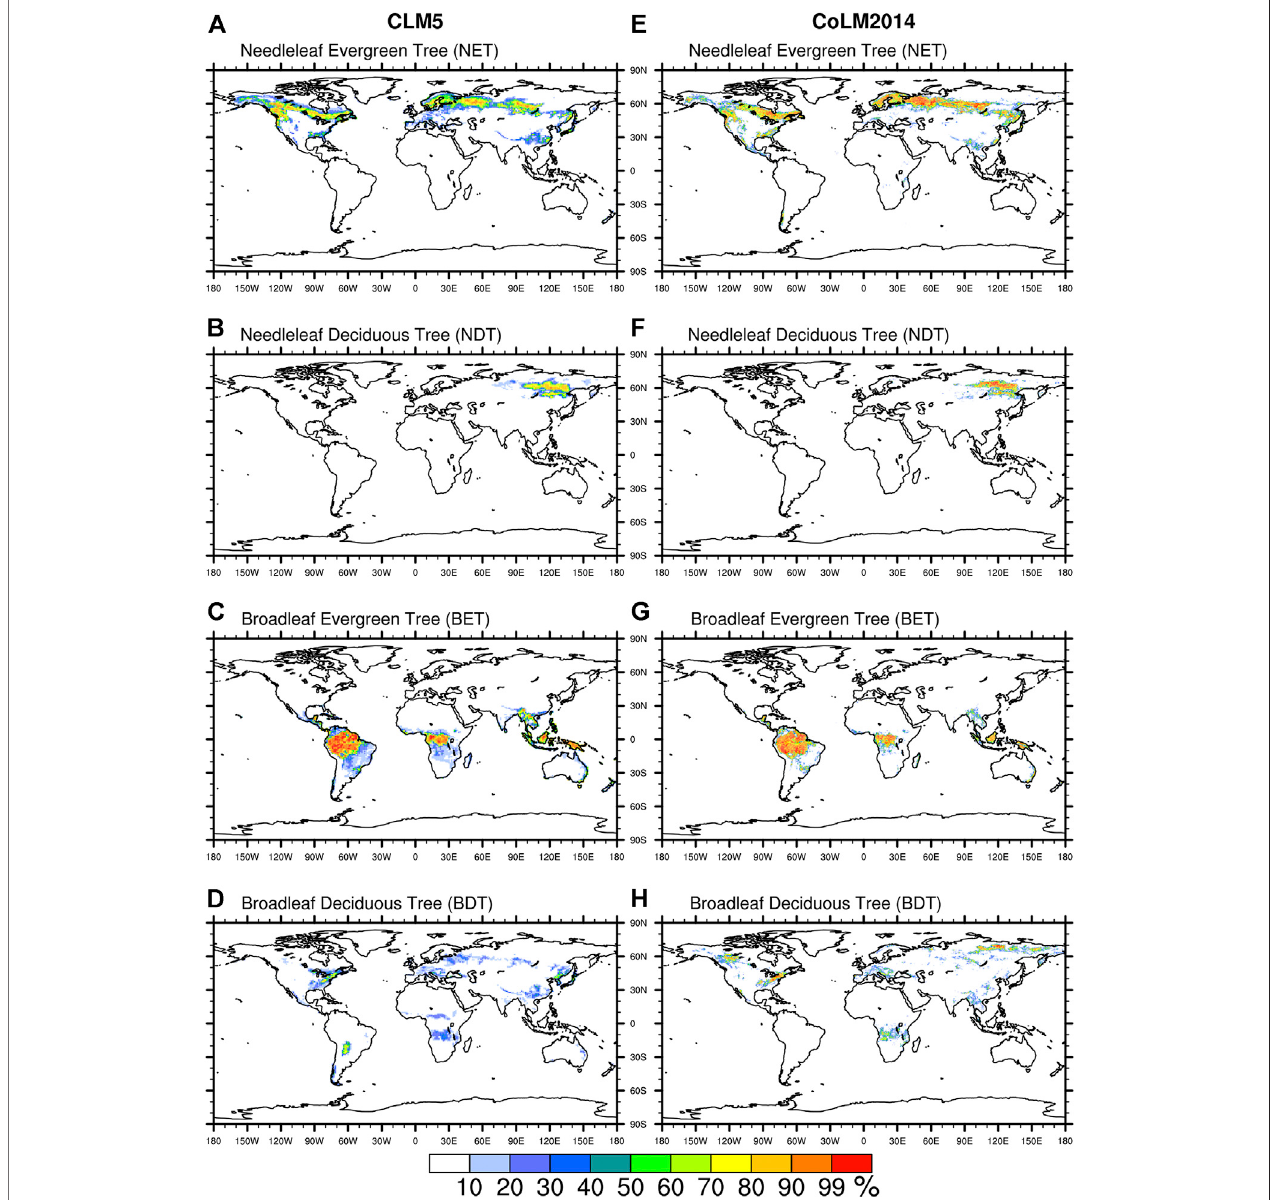
FIGURE 2 | Fractional coverage of different vegetation cover types in CLM5.0 (A – D) and CoLM2014 (E – H) .